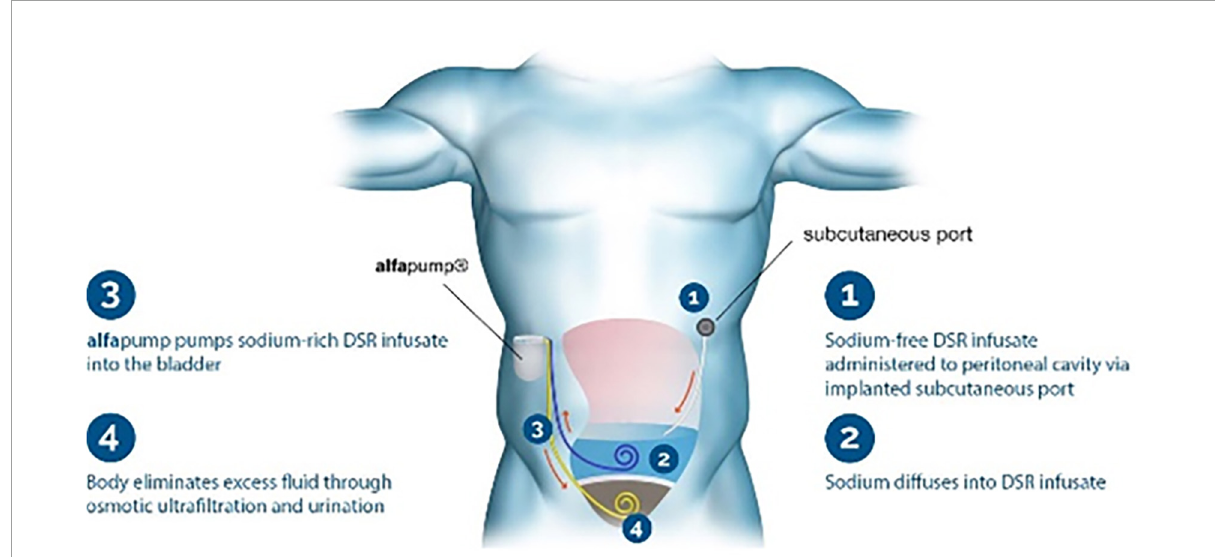
FIGURE1 Remover device. The Alfapump DSR system for sodium removal. Image used with permission from Sequana